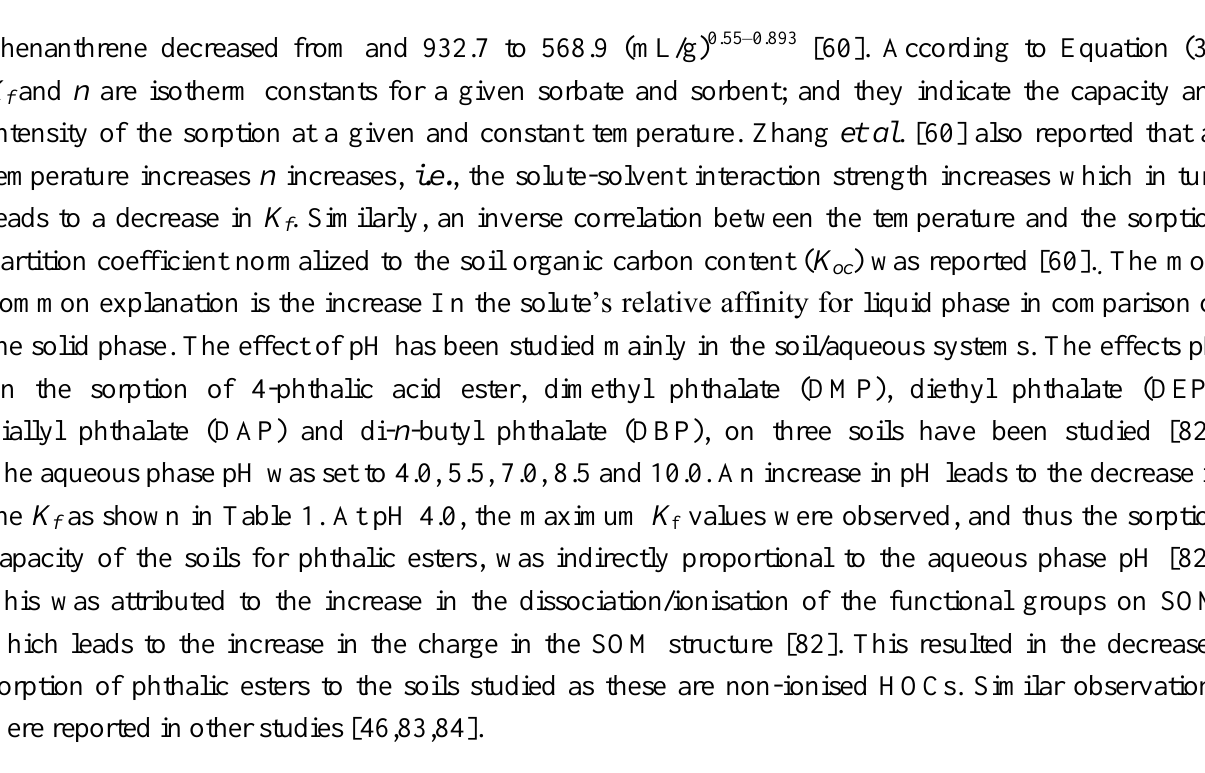
Table 1. The K values of the phthalic acid ester in relationship to pH (adapted f from reference